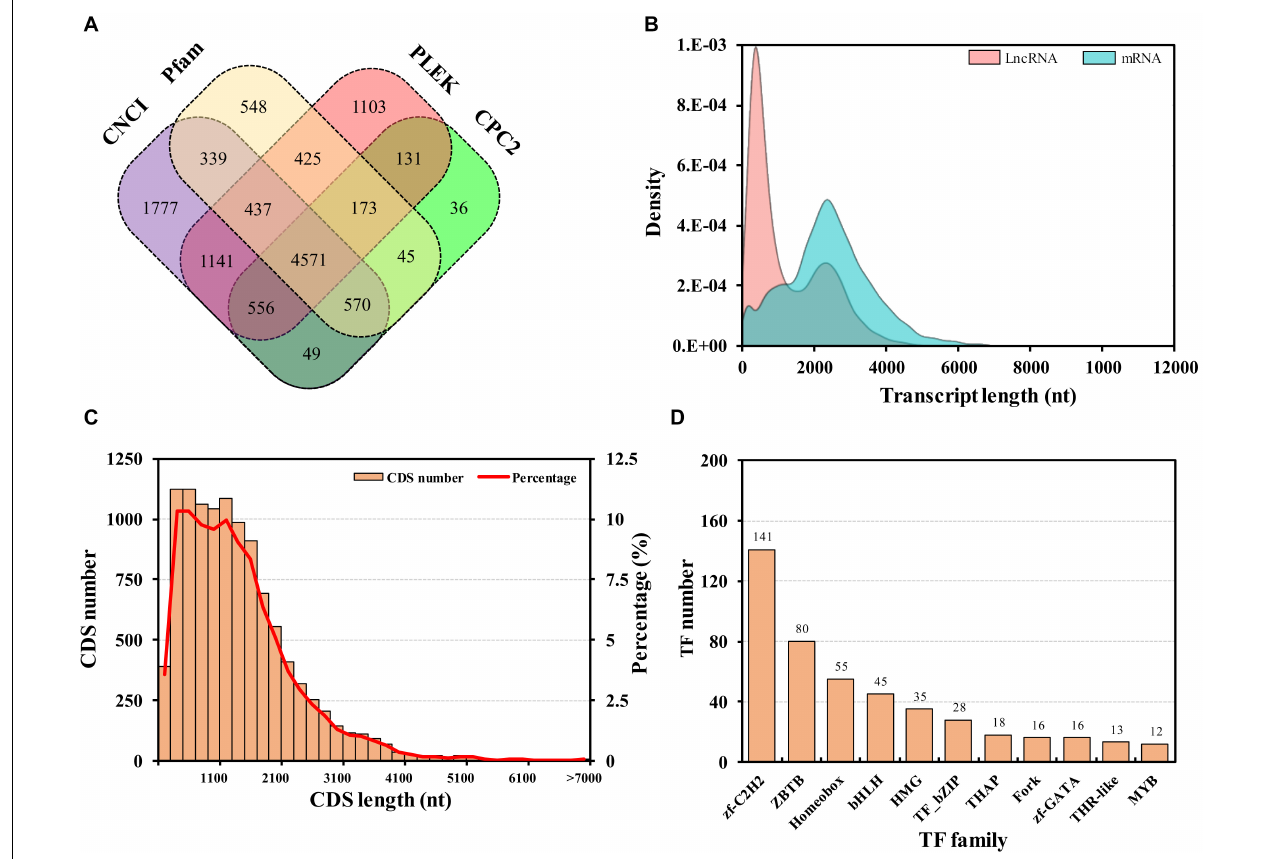
FIGURE 4 | Long non-coding RNA (lncRNA) prediction (A) , expression density of lncRNAs and protein-coding RNAs (mRNAs) (B) , length distribution of protein-coding sequences (CDSs) (C) , transcription factor (TF) family statistics (D) . LncRNAs were predicted using CNCI, Pfam, PLEK, and CPC2 computational